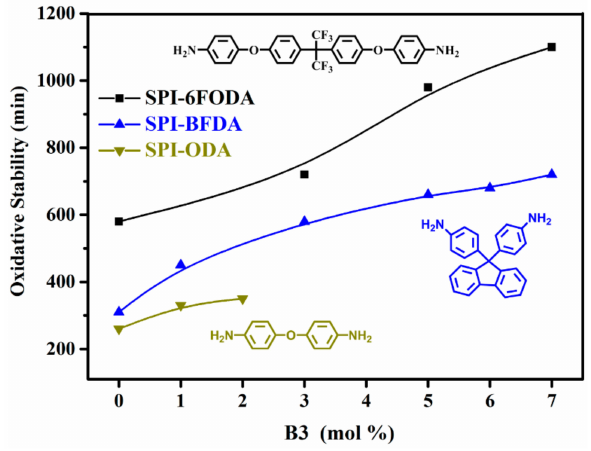
Figure 8. Oxidative stability of the three SPI based